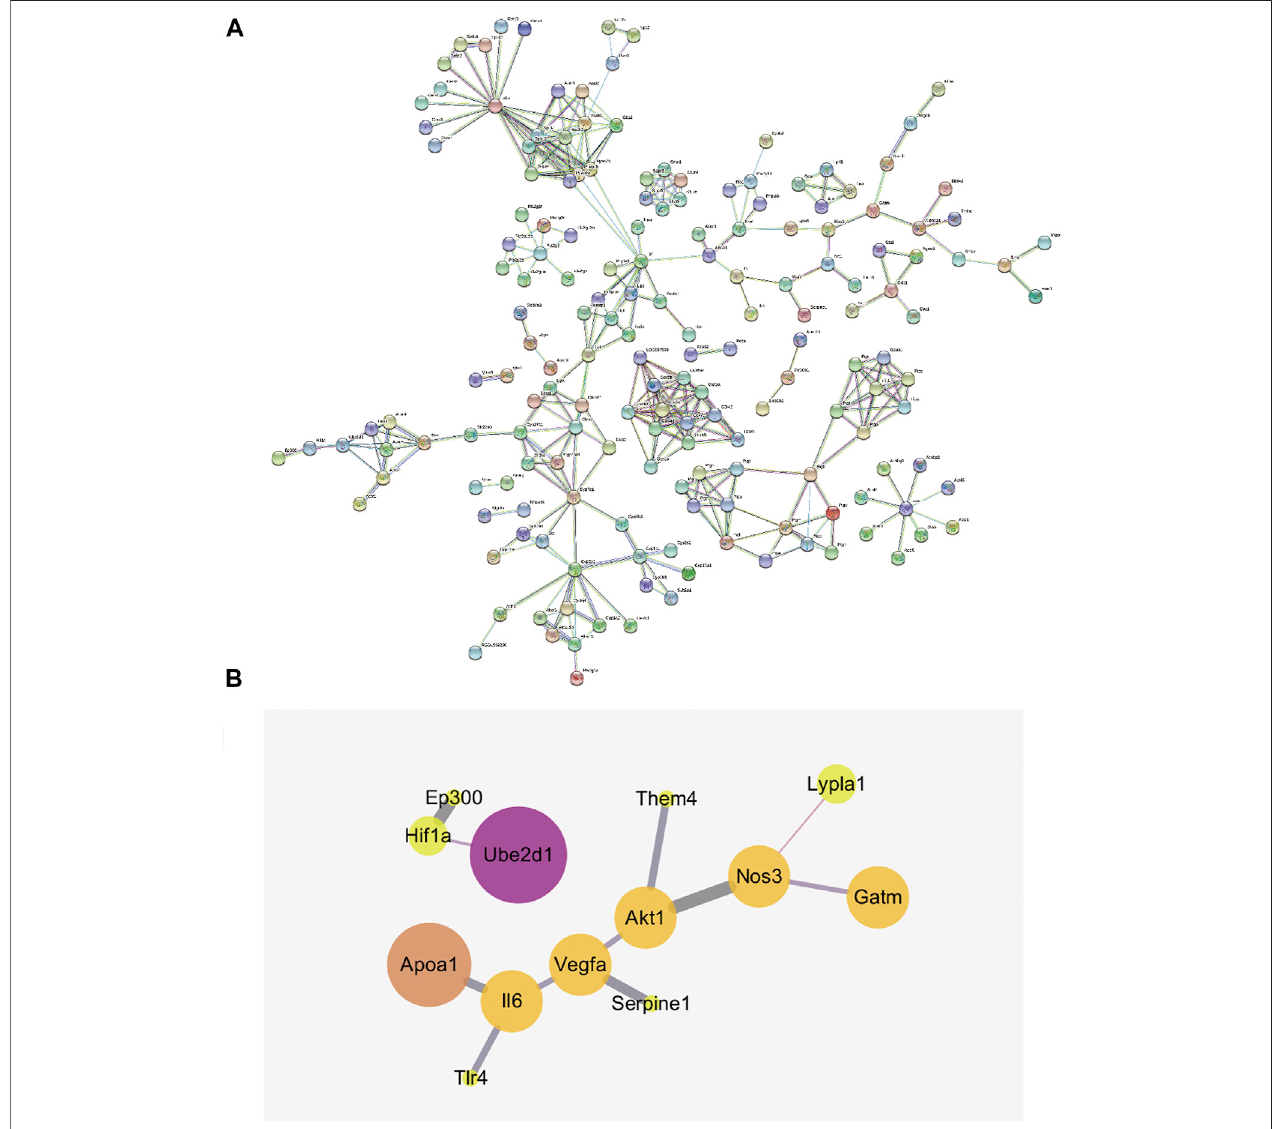
FIGURE 8 | (A) Gene interaction network (minimum required interaction score (cid:1) 0.9). (B) Network diagram of local interactions between metabolomics-related genes and HIF-1 signaling pathway-related